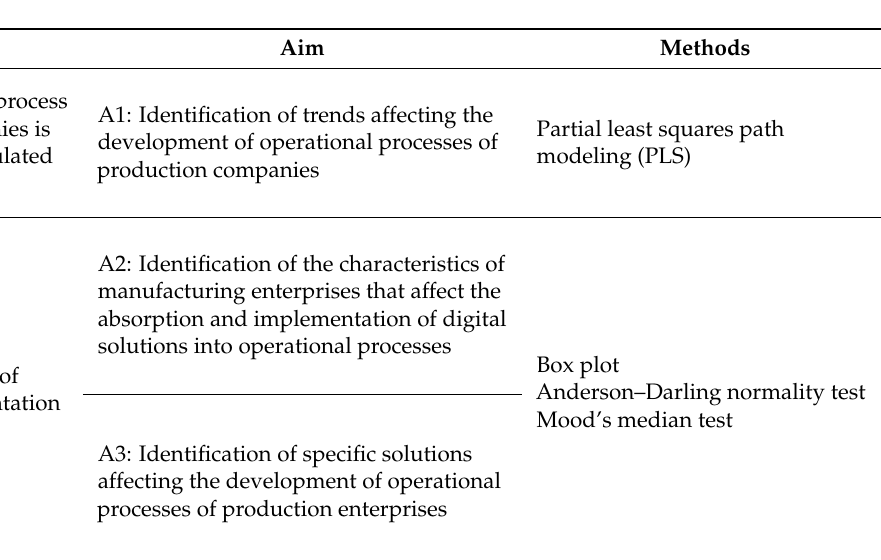
Table 5. Research